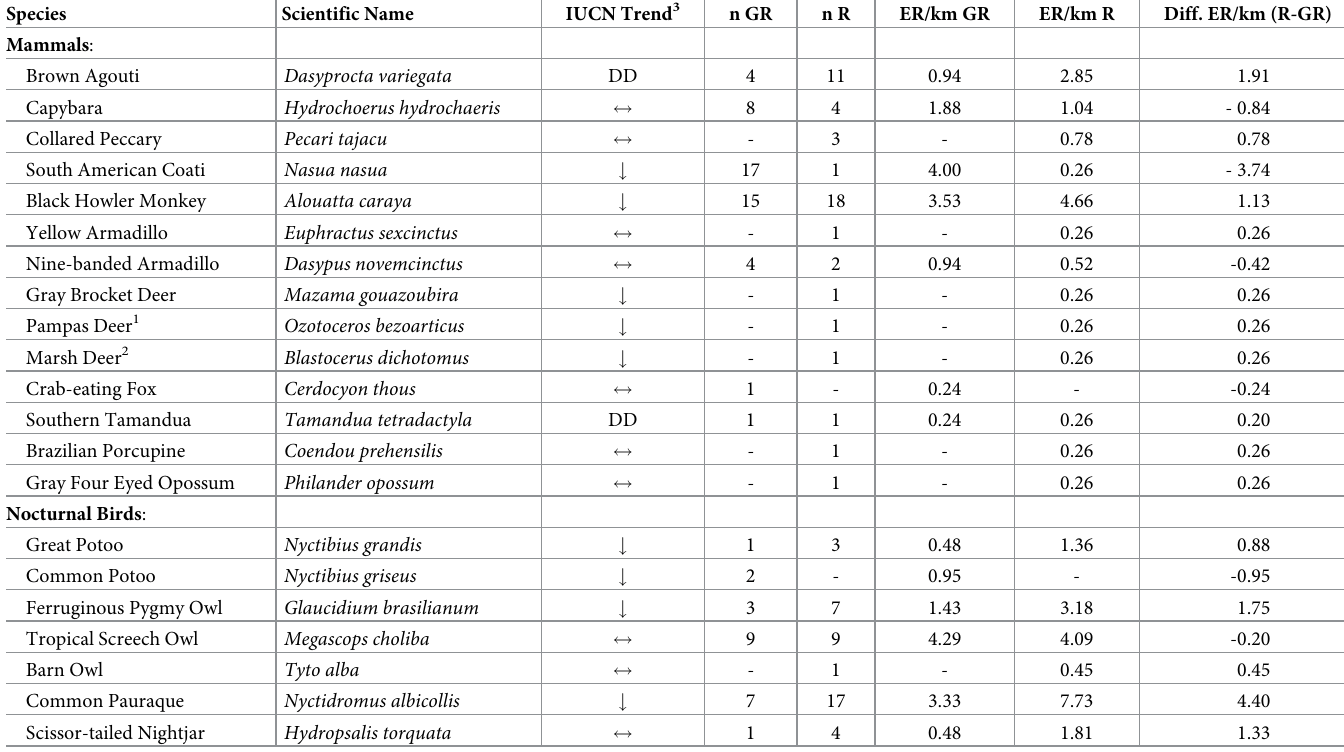
Table 3. Mammal and nocturnal bird species list and encounter rates per km (ER/km) on the grazed (GR) and restored (R)